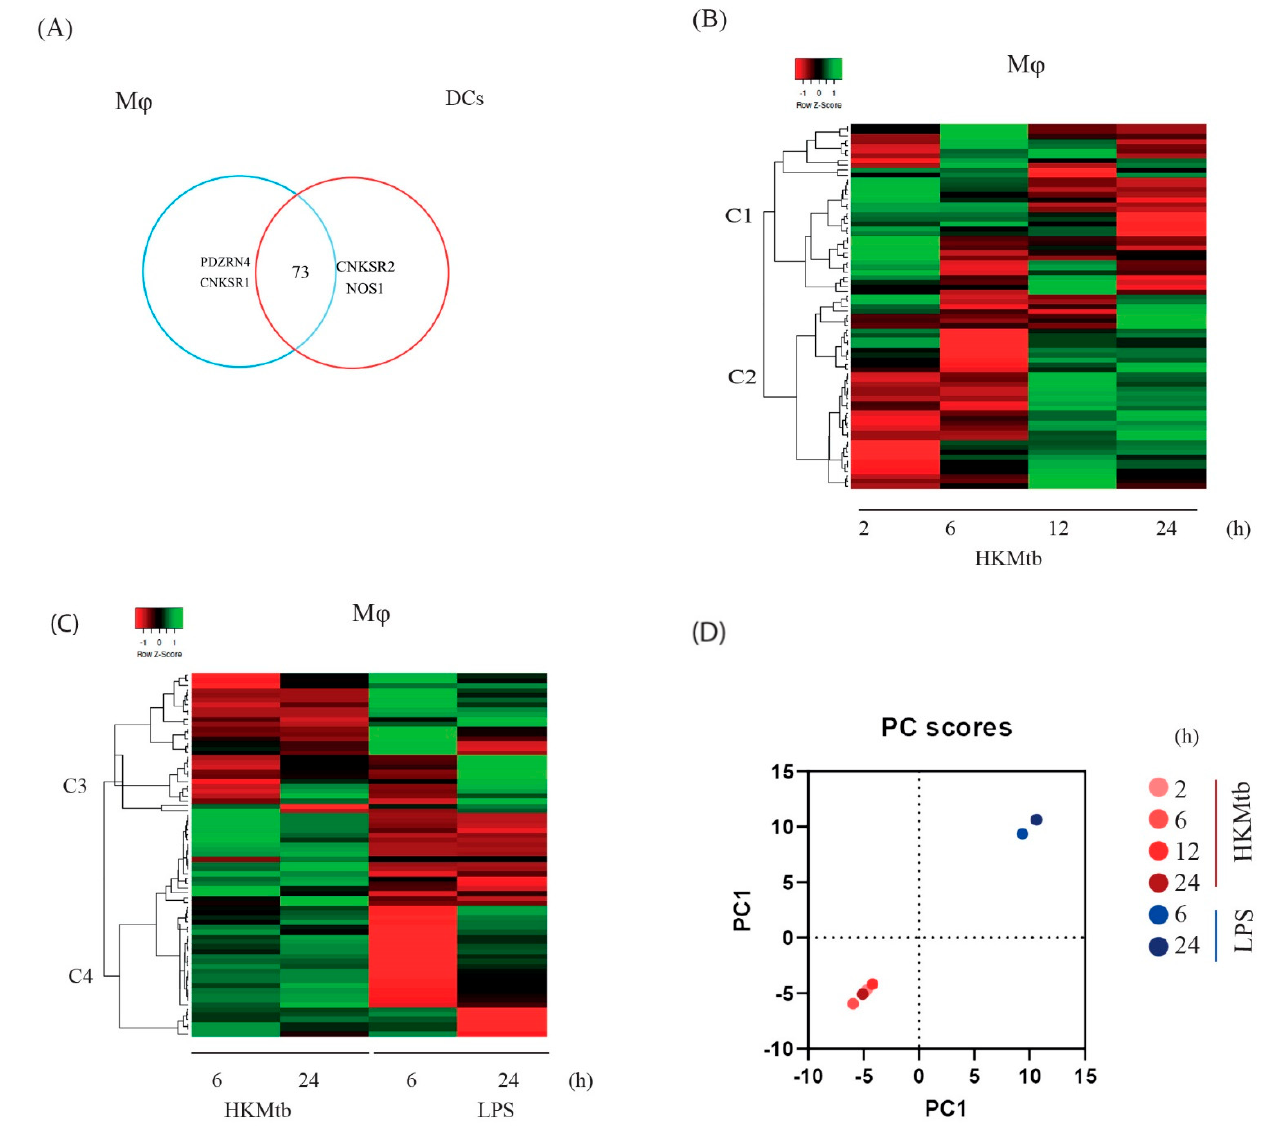
Figure 1. Different PAMPs induced specific PDZ gene expression patterns in human monocyte- derived M ɸ . ( A ) Venn diagram of PDZ genes expressed at baseline before stimulation in M ɸ and DCs. A total of 75 of the 83 gene panels were found to be expressed in M ɸ at baseline, eight genes were not expressed under basal conditions ( CARD10, CARD14, DLG2, MAGI1, MAGI2, MPP4, NOS1, CNKSR2 ). ( B ) Heatmap showing hierarchical clustering of the PDZ gene expression profile changes of M ɸ stimulated with HKMtb referenced to unstimulated M ɸ . Data are presented as Z– score, corresponding to the change of expression of each time point respect to the mean of changes during the entire time course, where negative Z–score indicates a decrease (red), and positive Z– score indicates an increase (green) of each PDZ gene. ( C ) Heatmap showing hierarchical clustering of PDZ gene expression profile changes of M ɸ comparing HKMtb (left) or LPS (right) stimulation for 6 and 24 h, referenced to unstimulated M ɸ . Data are presented as Z–score, where negative Z– score indicates a decrease (red), and positive Z–score indicates an increase (green) gene expression. ( D ) PCA analysis of qPCR data from M ɸ stimulated with HKMtb at 2, 6, 12, 24 h and with LPS at 6 and 24 h. PC1 explains 81.50% of the variance; thus, it is the only component represented in the graphic.